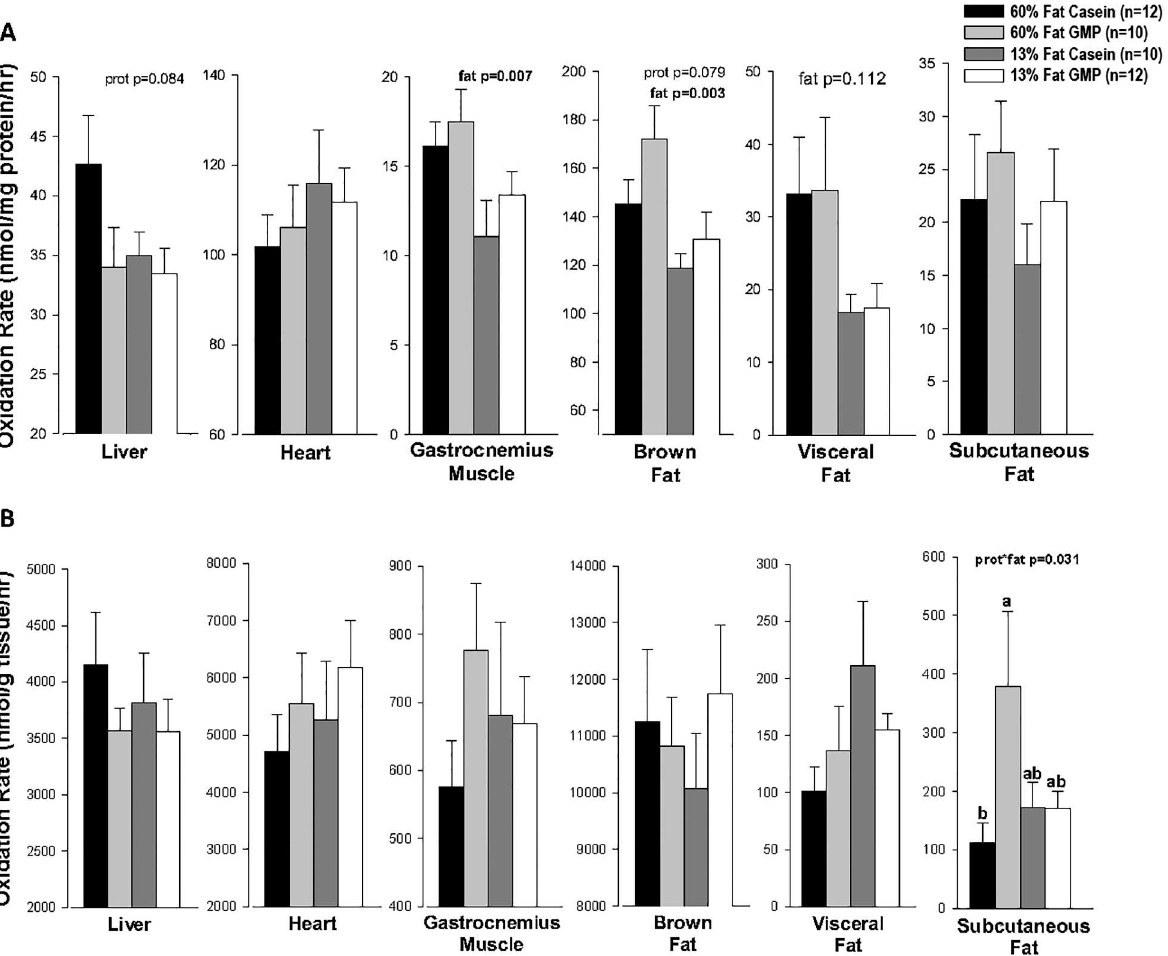
Fig 6. Total Fatty Acid Oxidation Rates. Total oxidationrate per mg protein (A) and per g tissue (B) in liver, heart, gastrocnemius muscle, brown fat, visceral fat, and subcutaneous fat tissues from female mice fed 60%-fat casein, 60%-fat GMP, 13%-fat casein, and 13%-fat GMP diets. Total fatty acid oxidationrate represents the sum of nanomolesof palmitate oxidizedto CO 2 and acid-soluble metabolites per hour. a,b Means with different superscripted letters are significantly different (p < 0.05). Values are means ± SE; nos. in parentheses indicate sample size. There was a significant fat effect in oxidationrate per mg protein on gastrocnemius muscle and brown fat tissue where mice fed the high-fat diets had greater oxidationrates than mice fed the control diets (A). In subcutaneous fat tissue, there was a significant prot * fat interaction of total fatty acid oxidationrate per g tissue where mice fed the 60%-fat GMP diet had increased fat oxidizedcompared to mice fed the 60%-fat casein diet (B).